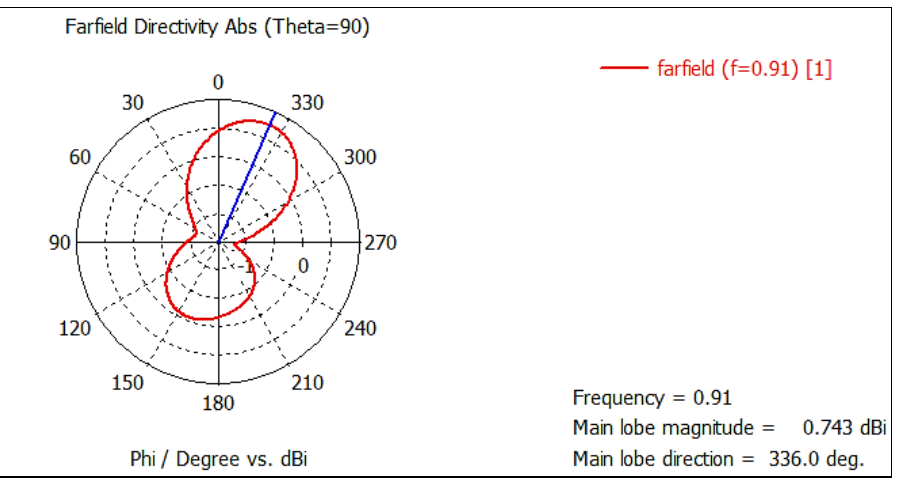
Figure 12. Antenna pattern at first frequency ( 𝑻𝒉𝒆𝒕𝒂 = 𝟗𝟎 )